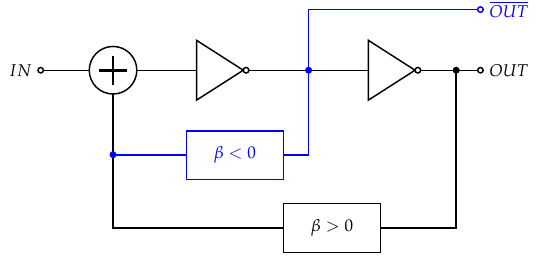
Figure 6. Schmitt trigger implemented with a double inverter. The complementary output is optionally available and/or can be optionally used to create the positive feedback (blue